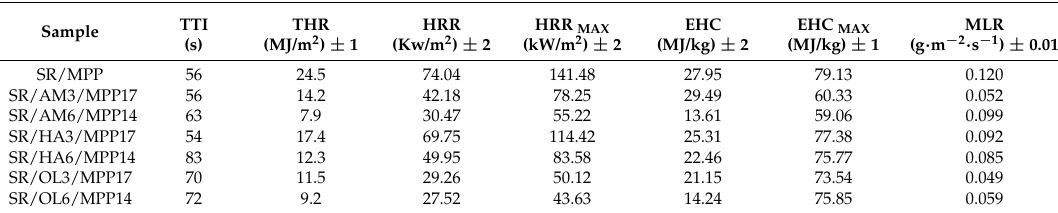
Table 8. Flammability composites of SR/POSS/MPP.